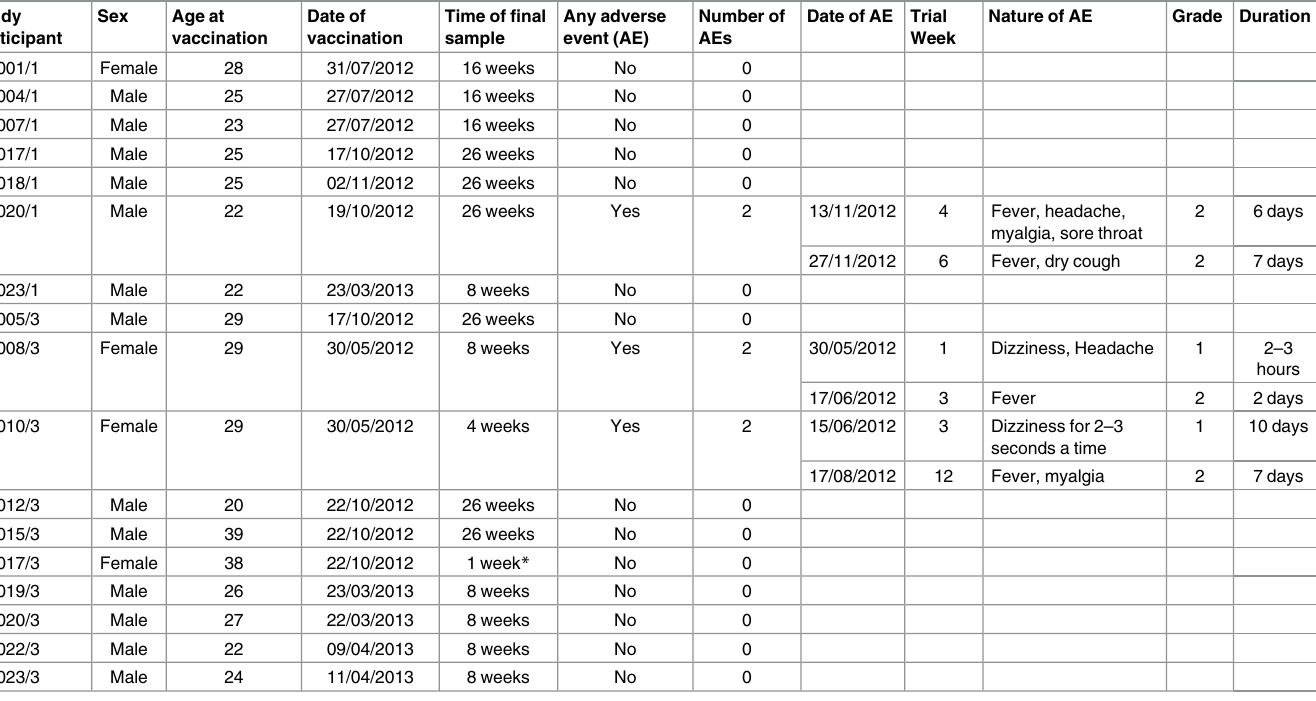
Characteristics of the 17 participants and reactions to the vaccine in the study are shown. Adverse events (AE) occurred in three participants, the other 14 participants did not report any adverse